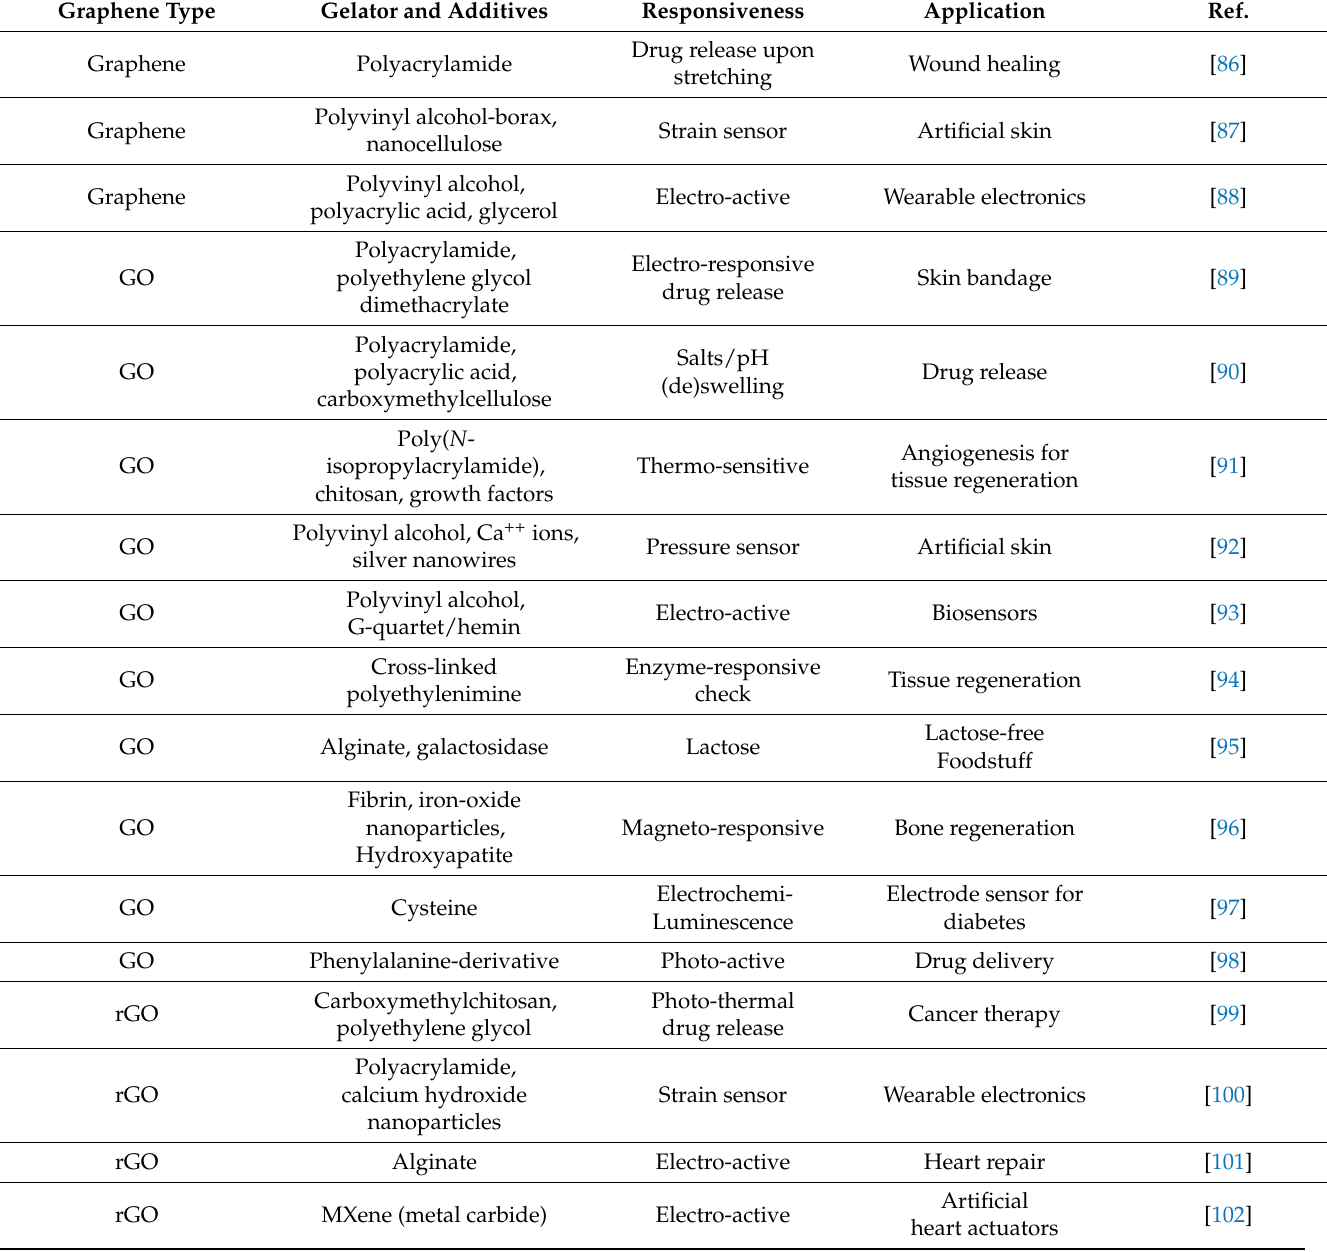
Table 1. Recent examples of smart hydrogels with graphene for biomedical applications. GO = graphene oxide, rGO = reduced